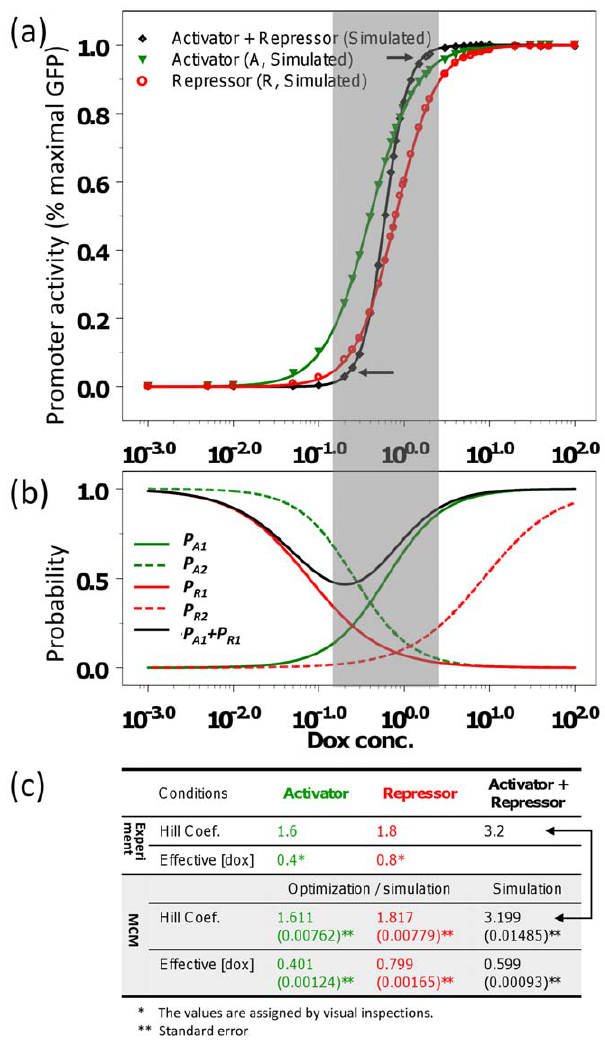
Figure 4. Model prediction matches more closely to the experimental observation. (a) Simulated dose-response relationship between [dox] and promoter activity (normalized gene induction levels). (b) Hill functions showing estimated switching probabilities ( P A1 , P A2 , P R1 , and P R2 ) against [dox]. Values of P A1 + P R1 against [dox] are also shown. To show the relationship between (a) and (b), these graphs are aligned by the [dox]. (c) Comparisons between model predictions and experimental